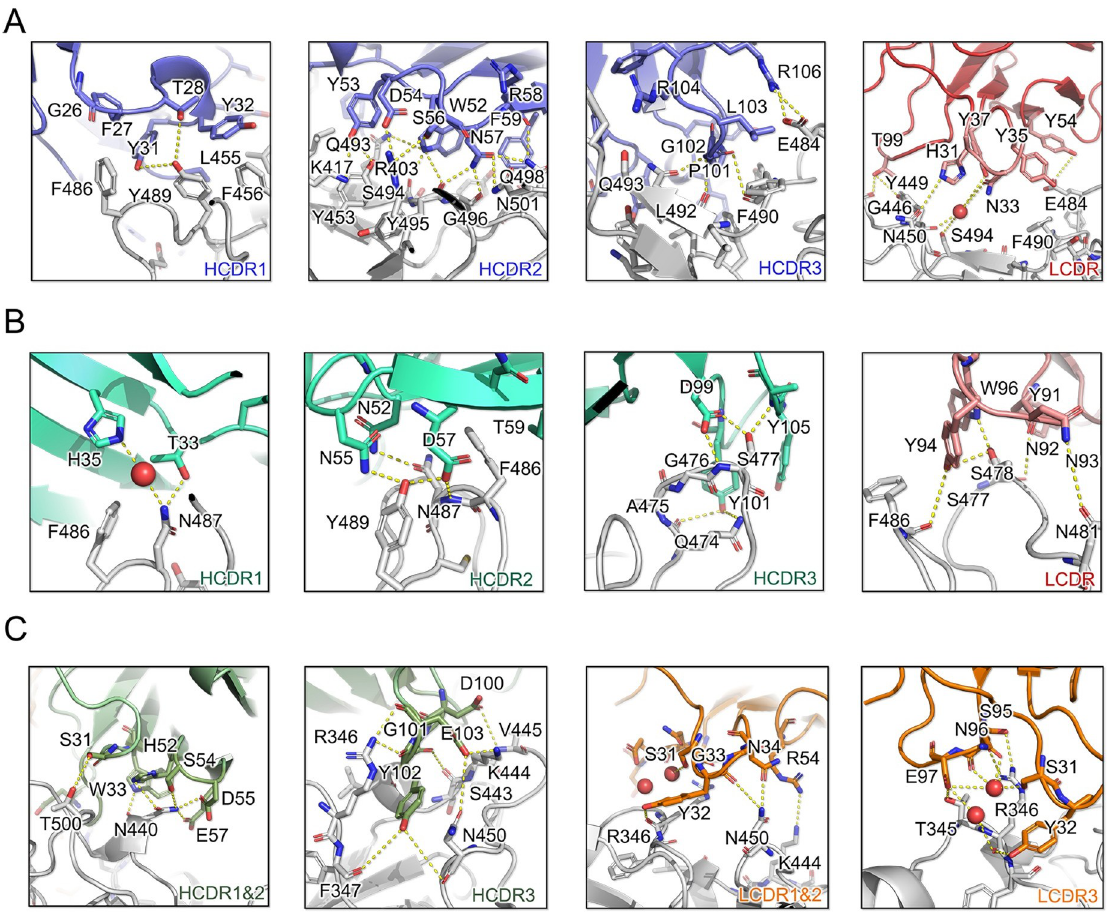
Fig 4. Interactions between the SARS-CoV-2 RBD and CDR loops. (A–C) Detailed analysis of the interfaces of SARS-CoV-2 RBD with HCDR and LCDR for (A) PR1077, (B) PR953, and (C) PR961. For clarity, only the key residues are labeled: red, oxygen atoms; blue, nitrogen atoms; yellow dash lines, hydrogen bond interactions. The residues are shown in sticks with identical colors to Fig 3; water molecules are displayed as red spheres. CDR, complementary-determining region; HCDR, heavy chain complementarity-determining region; LCDR, light chain complementary-determining region; RBD, receptor-binding domain; SARS-CoV-2, Severe Acute Respiratory Syndrome Coronavirus 2.